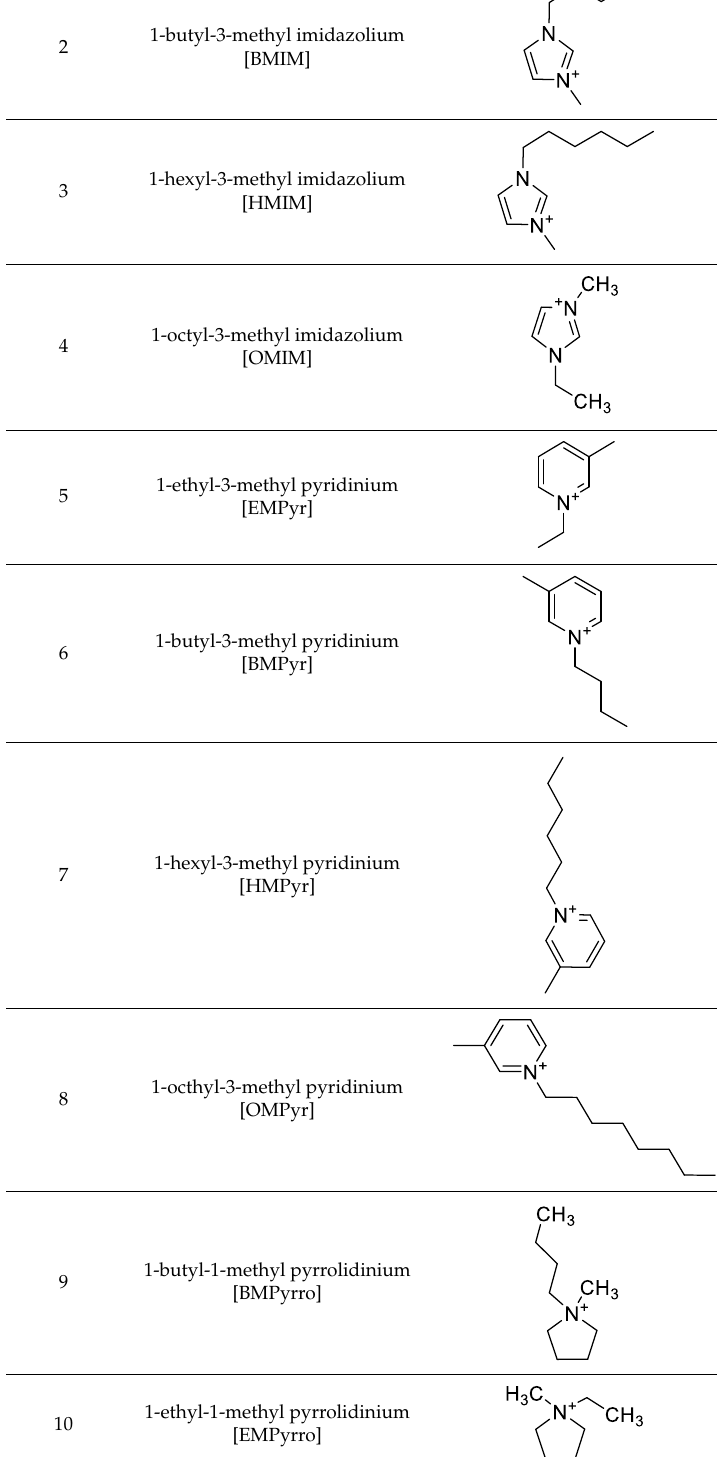
Table 4. The screened cations used in this study.